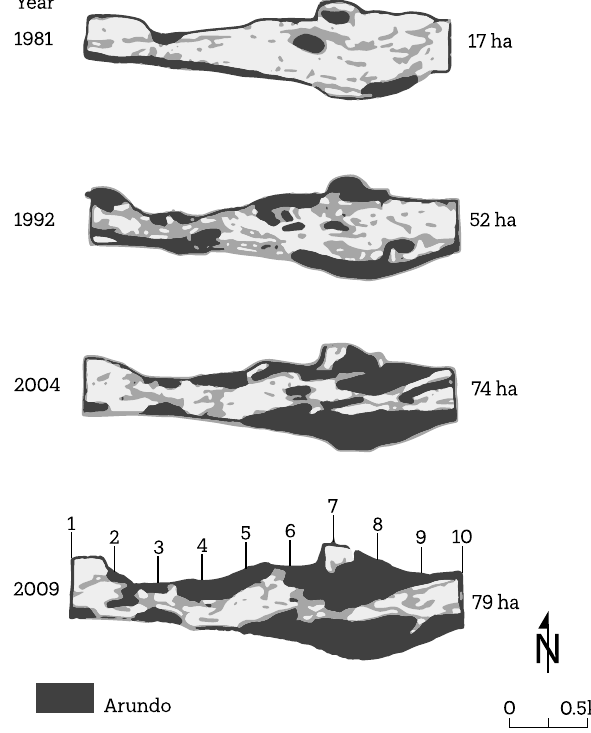
Figure 5. Maximum extent of Arundo donax (black) and other vegetation (grey) at site S1 measured from aerial photograph years that represent the maximum amount of time since the last major flood. A. donax has increased 350% at a growth rate of 2.2 ha/year. Flow is from right to left. Locations of cross sections where channel characteristics were measured are shown.